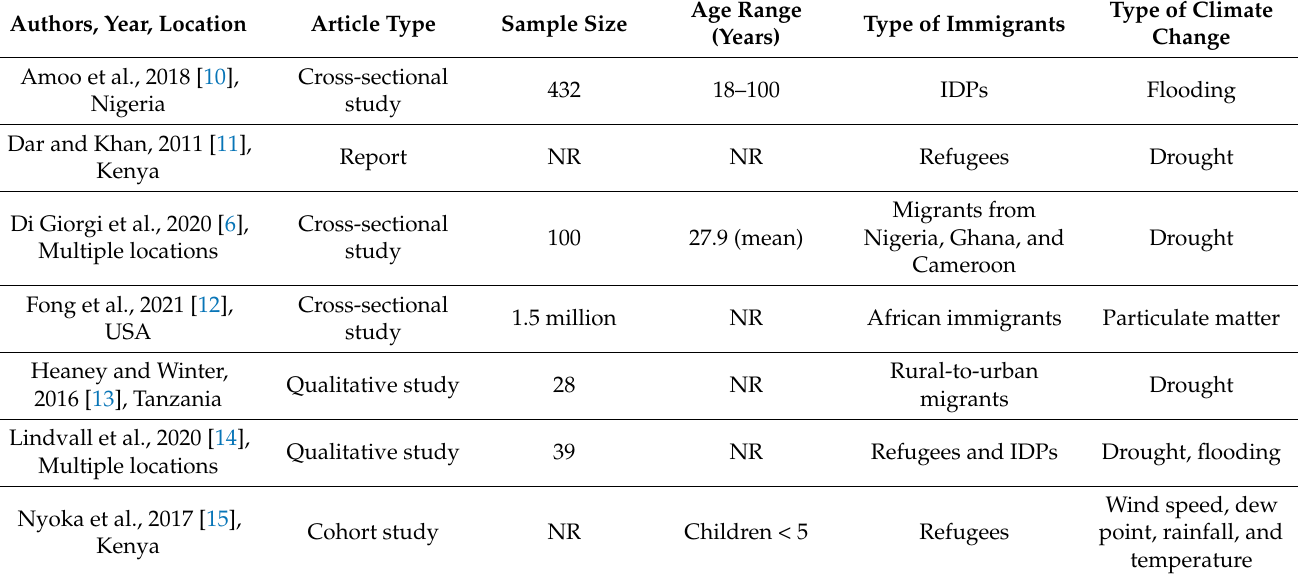
Table 1. Characteristics of included